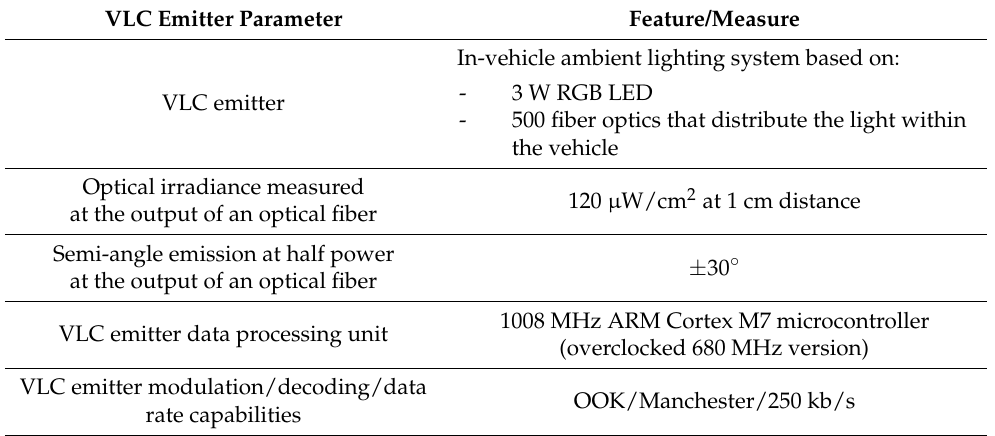
Figure 3. Schematic representation of the proposed in-vehicle visible light communications system. Table 1. Visible light communications emitter parameters.